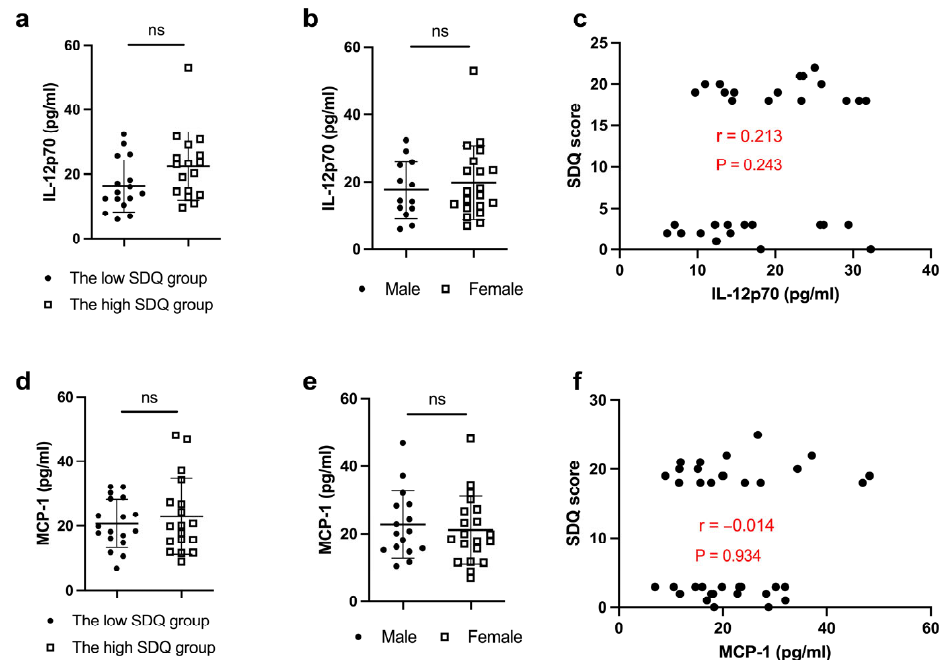
Figure 3. Comparison of plasma cytokine levels between low and high SDQ groups, including sex ‐ specific changes. ( a ) Difference in IL ‐ 12p70 expression level between the low ( n = 16) and high SDQ group ( n = 17), ( b ) difference in IL ‐ 12p70 expression level between male ( n = 13) and female ( n = 20), ( c ) interaction of the SDQ score with the level of IL ‐ 12p70, ( d ) difference in MCP ‐ 1 expression level between the low and high SDQ group ( n = 18/group), ( e ) difference in MCP ‐ 1 expression level between male ( n = 18) and female ( n = 20), ( f ) interaction of the SDQ score with the level of MCP ‐ 1. Note: outliers were removed separately from each graph based on the used method. ns: non ‐ significant.